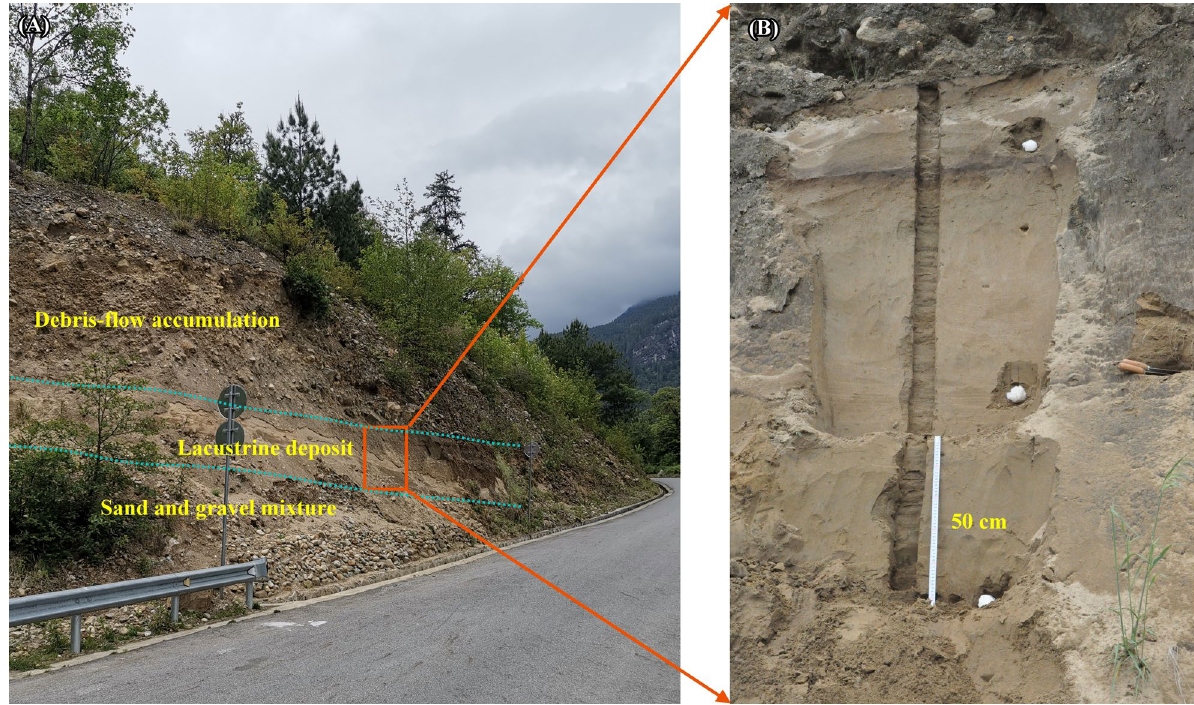
Figure 3. ( A ).The sediment sequence at the outlet of Dayi creek. ( B ) Section of the lacustrine deposit between the debris-flow accumulation and the mixed layer. The ruler is 50 cm Peak flow reconstruction. There are no direct records of the basic parameters of the 1902 AD and 7 ka BP floods such as breach depth and peak discharge. The well-documented 2000 AD flood can be used as a benchmark to aid the reconstruction of historic events. The peak 2000 AD discharge at Tongmai Bridge has been estimated as 126,400 m 3 /s 13 , 120,000 m 3 /s 12 , and 124,000 m 3 /s 21 , with a peak water depth of 52 m. We com- pare peak discharge calculations for the 2000 AD flood using 15 empirical formulas and known data on breach depth, dam height, volume of released water, and impounded water volume (Tables 3, 4) 22 . The MacDonald and Langridge-Monopolis (MLM) 23 formula produced the closest estimate to the measured discharge, at ~ 130,000 m 3 /s. Therefore, the MLM formula is used to estimate the peak discharge of the 1902 AD event using a breach height of 75 m 12 and the empirical relationship between the lake area and its volume from Delaney and Evans 15 (Table 4). The resulting discharge of the 1902 AD event is ~ 182,000 m 3 /s, more than 50 times a normal seasonal flood discharge in the Yigong. SWD surface elevation is widely used in paleoflood hydraulic reconstruction as a PSI 18,24 . The most commonly used paleoflood peak discharge estimation technique is the 1-D step-backwater method 18,25 . We applied the method to the 2000 AD and 7 ka BP events using 1-D steady flow analysis of HEC-RAS 5.0.7 software 26 , assuming a subcritical flow regime. Contour lines interpolated from the ALOS DEM (released in 2014 with 12.5 × 12.5 m spatial resolution) correspond well with channel shape and location in the ETM + image in 1999, so they provide an acceptable record of pre-2000 AD topography. The starting cross-section for the step-backwater calculation was set at the Tongmai Bridge bedrock section. A total of 97 cross sections were extracted along the 19.2 km reach with an average spacing of 200 m using the RAS Mapper of HEC-RAS 5.0.7 (Fig. 5A). Expansion and contraction coefficients of 0.1 and 0.3 were specified based on channel width 26 . Manning’s roughness coefficient n was calibrated using the peak discharge (126,000 m 3 /s) and water depth (52 m) of the 2000 AD flood. The computed water surface elevation at the Tongmai and Jiazhong cross-sections corresponded well with the 2000 AD flood level when Manning’s roughness coefficient was set as 0.03 and 0.035 for the river channel and floodplain, respectively. The roughness values are also the suggested values for the mountain stream such as the Yigong River (channel bottom with gravels, cobbles, and few boulders, no vegetation in channel, and steep banks with trees and brush probably submerged) 26 . The calculated values of the velocity and flow area of the 2000AD flood at Tongmai Bridge are 15.7 m/s and 8350 m 2 , respectively, which are close to those estimated by Delaney and Evans 15 . Sensitivity tests in the model show that a 25% variation in Manning’s roughness coefficient results in variation of 2.65–2.76% in flood water depth and variation of 0.12–0.15% in peak discharge. Using these values of the coefficients, a discharge of 225,000 m 3 /s provides the best approximation for the Shuangyu deposits (Fig. 5B). For the 7 ka BP flood, the velocity and the flow area at Tongmai Bridge are 19.5 m/s and 12,360 m 2 , respectively. The paleoflood with such a magnitude can yield a bed shear stress of 5 kPa and move large boulders up to 5–6 m in diameter 8 .